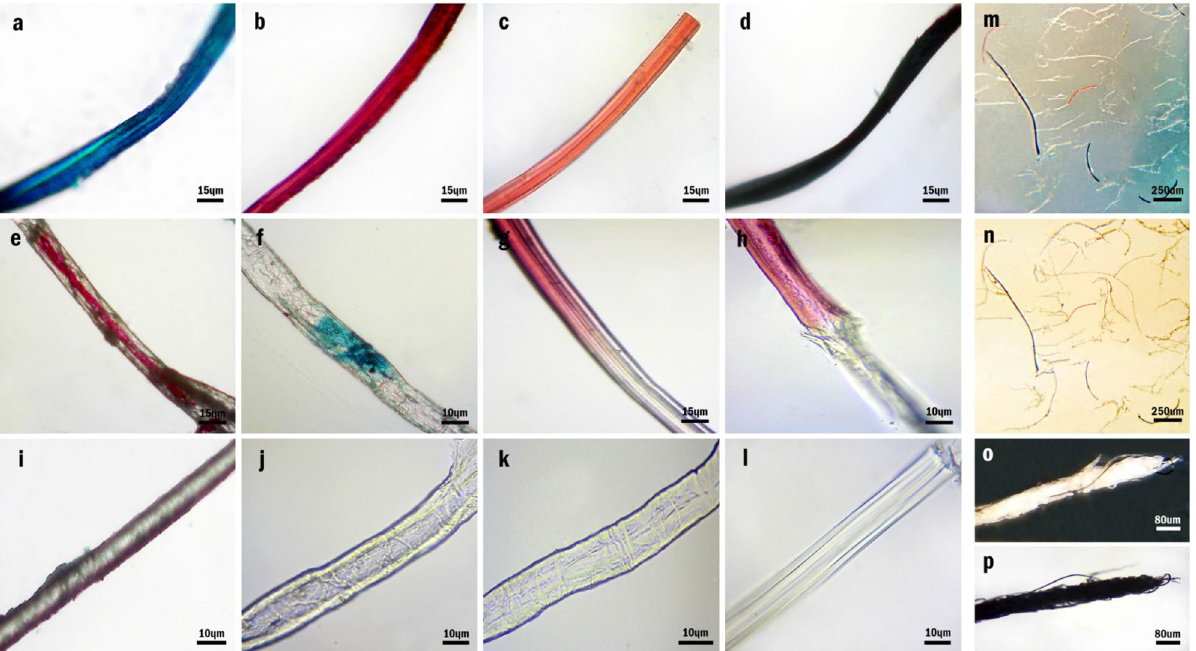
n ) OM images of NOG fibers under episcopic and diascopic illuminations. ( o–p ) OM images of self-assembled yarn under episcopic and diascopic